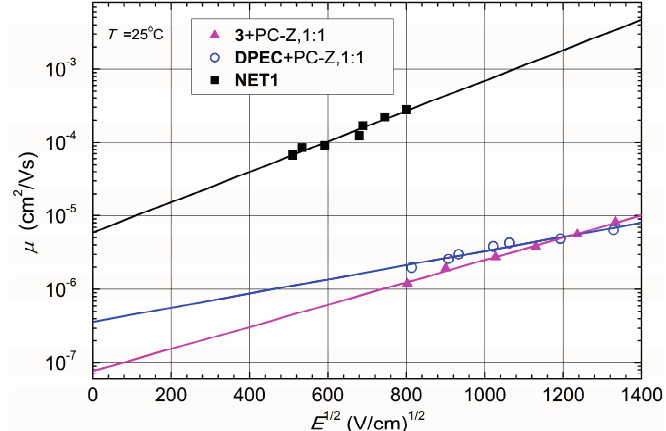
Figure 6. Electric field dependence of the hole drift mobility in charge transport layers of 3 and DPEC doped in PC-Z and in the cross-linked layer NET1